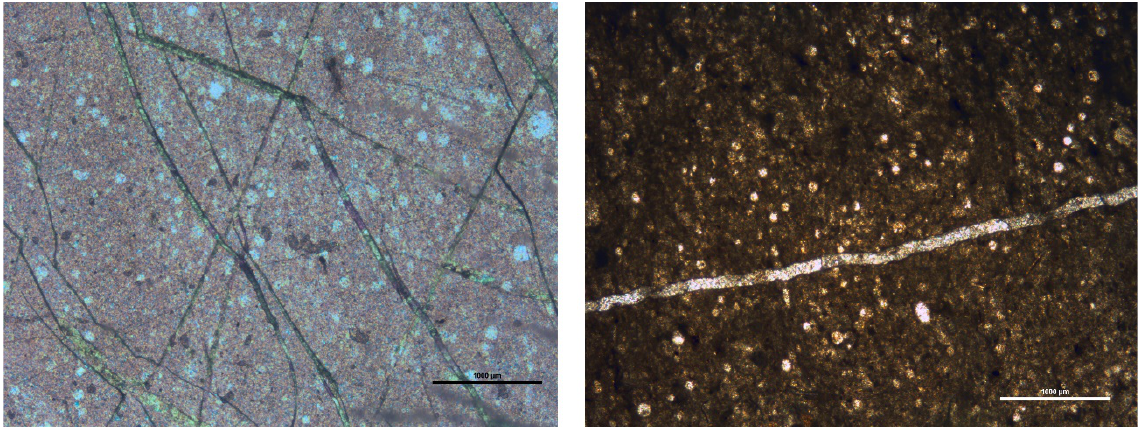
Figure 7. Geological flint. Petrographic analysis. (Crossed polarisers). Scale bars are 1 mm